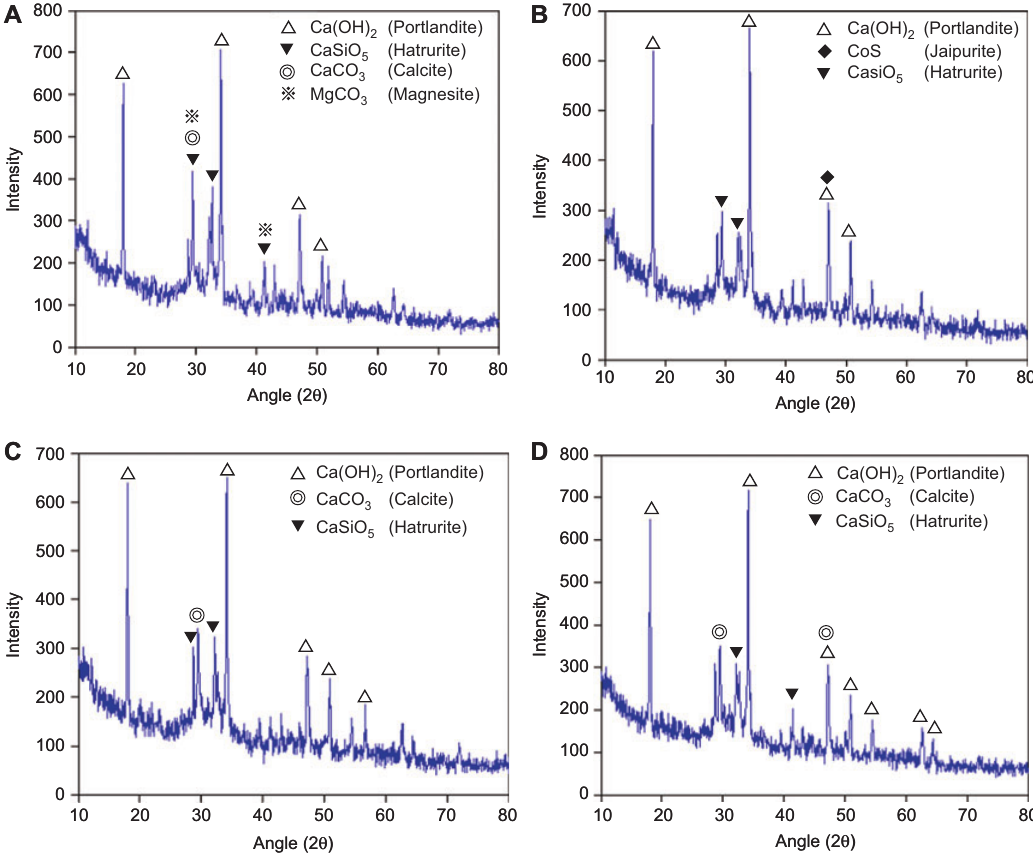
Figure 12 Typical XRD patterns of cement paste (A) without montmorillonite, (B) with 5 % montmorillonite, (C) with 10 % montmorillonite, (D) with 15 % montmorillonite.